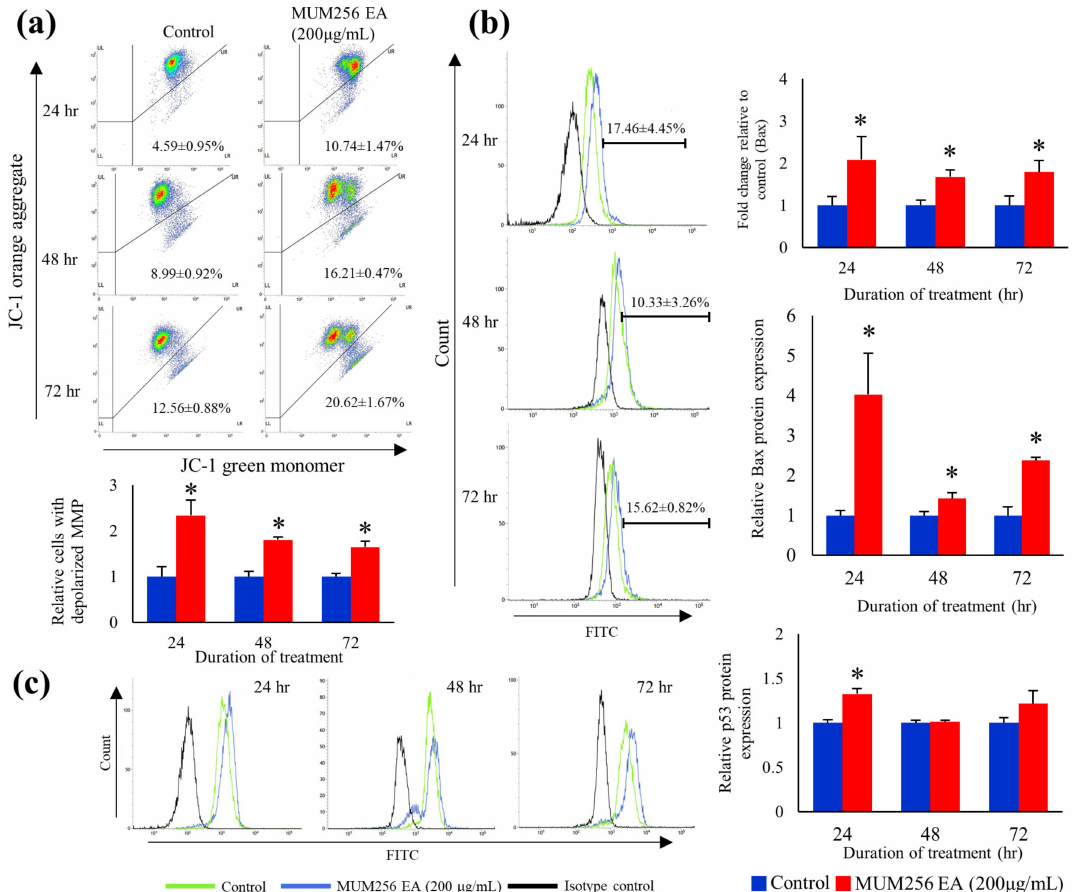
Figure 8. E ff ect of MUM256 EA on the mitochondrial membrane potential, proapoptotic protein (Bax) and p53 status in HCT116 cells. ( a ) HCT116 cells were treated with MUM256 EA for indicated durations and then were stained with JC-1 dye to detect the change of MMP by flow cytometry. Dot plots are representative of three independent experiments. Bar graph shows the ratio of JC-1 orange / green normalized to control, decrease in the ratio indicating MMP depolarization upon treatment, * p < 0.05 ( n = 3). ( b ) Real-time PCR analysis of Bax expression in HCT116 cells treated with 200 µ g / mL MUM256 EA fraction. The fold change of the gene was normalized against porphobilinogen deaminase (PBGD) expression using the formula 2 − ∆∆ CT . Flow cytometry analysis of Bax protein expression in HCT116 cells using intracellular immunofluorescence staining method. Representative overlay of histograms showing Bax-associated fluorescence intensity after exposure to MUM256 EA fraction at 200 µ g / mL for 24, 48 and 72 h. Bar graph represents the relative expression levels of Bax protein in treated HCT116 cells compared to control. Values are mean percentage of cells with expressed Bax ± SD. of three independent experiments. Asterisks indicate a significant di ff erence compared to control (* p < 0.05). ( c ) Flow cytometry analysis of p53 protein expression in HCT116 cells using intracellular immunofluorescence staining method. Representative overlay of histograms showing p53-associated fluorescence intensity after exposure to MUM256 EA fraction at 200 µ g / mL for 24, 48 and 72 h. Relative expression levels of p53 protein in HCT116 cells. Values are median fluorescence intensity ± SD of three independent experiments. Asterisks indicate a significant di ff erence compared to control (* p <